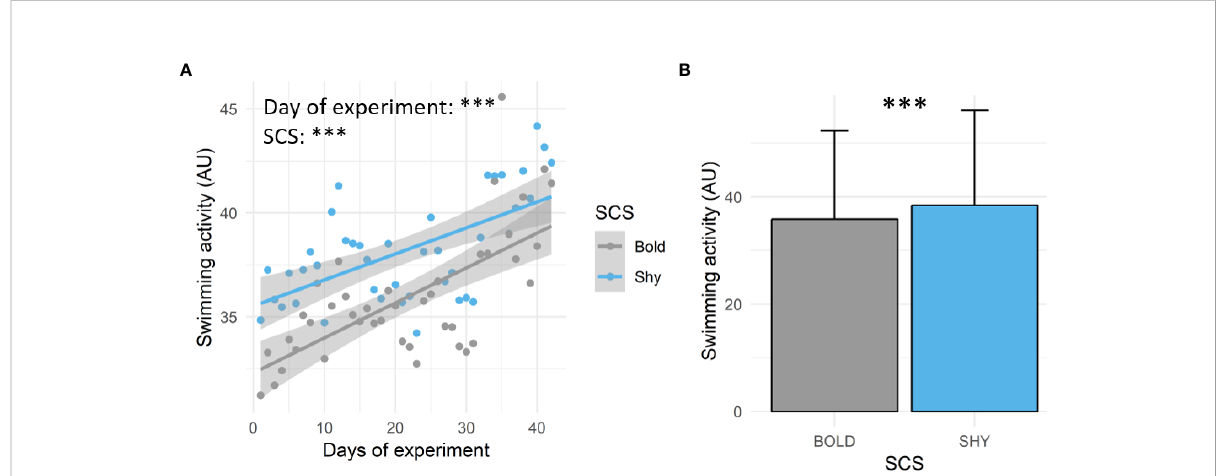
FIGURE 2 Swimming activity (AU) recorded in bold (gray, n = 9) and shy (blue, n = 9) fi sh during the experiment. (A) Mean daily values of swimming activity (AU) and linear regressions between swimming activity, days of the experiment, and SCS (bold or shy). (B) Mean ± SD of swimming activity (AU) depending on the SCS (bold or shy). For both panels, signi fi cance differences are indicated [the linear model for panel (A) and GLME for panel (B) ; *** p <